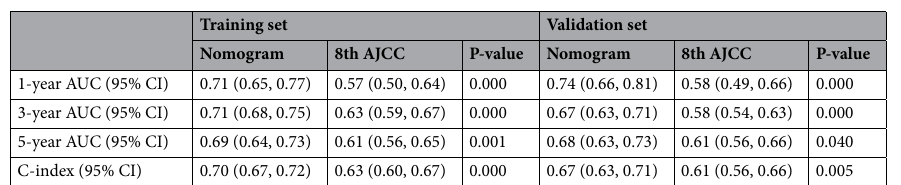
Table 3. Comparison of time-dependent AUC and C-index between the nomogram and the 8th AJCC staging system. AUC area under the receiver operating characteristic curve, CI confidence interval, AJCC American Joint Committee on Cancer.